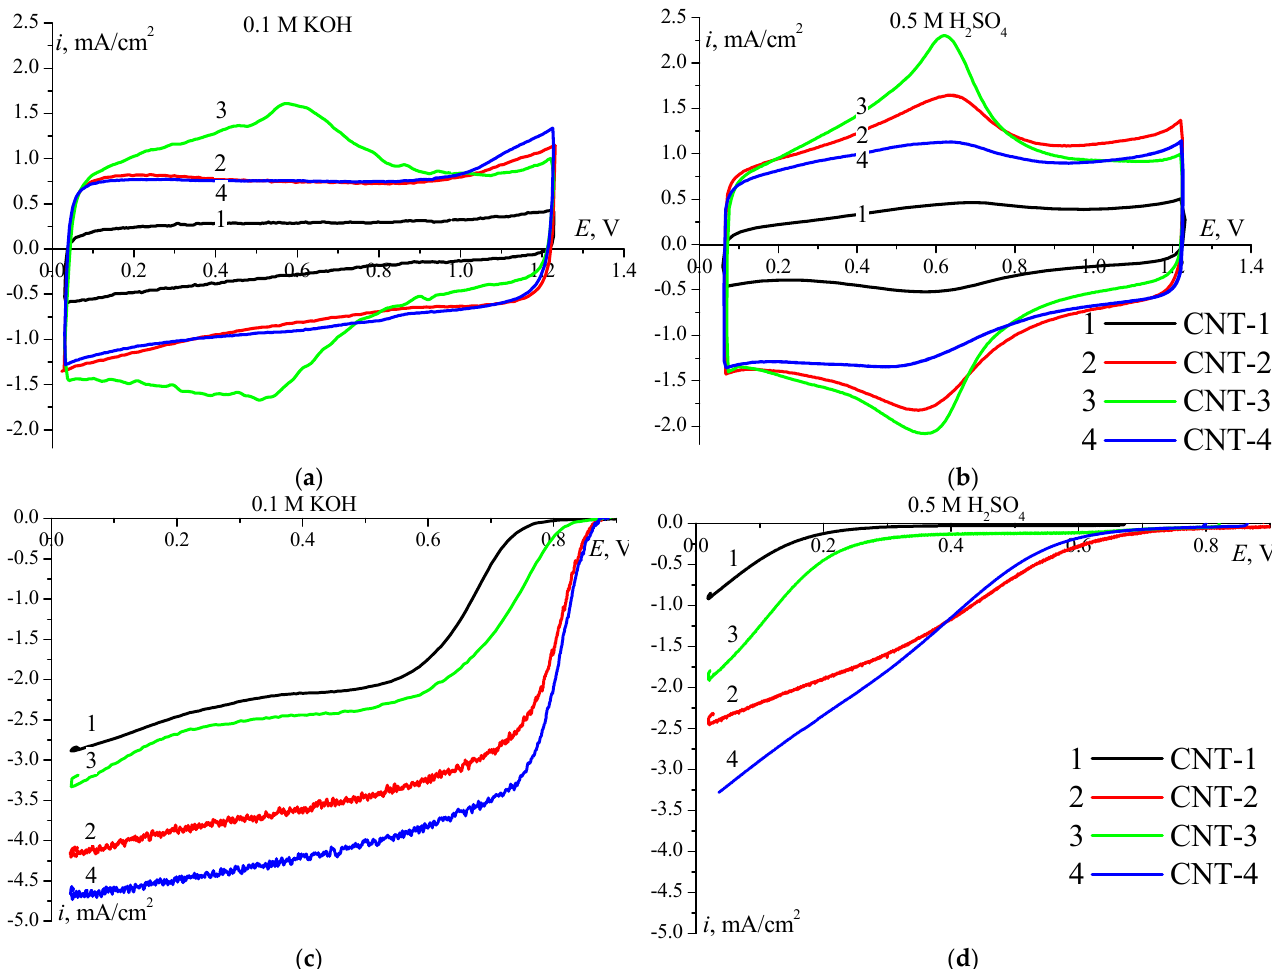
Figure 3. CV on modified CNT in 0.1 M KOH ( a ) and in 0.5 M H 2 SO 4 ( b ) electrolyte solution. Ar-saturated, 100 mV/s, 0.150 mg/cm 2 . Polarization curves of О 2 reduction on modified CNTs in 0.1 M KOH ( c ) and in 0.5 M H 2 SO 4 ( d ) electrolyte solution, 5 mV/s, 1500 rpm, 0.150 mg/cm 2 .